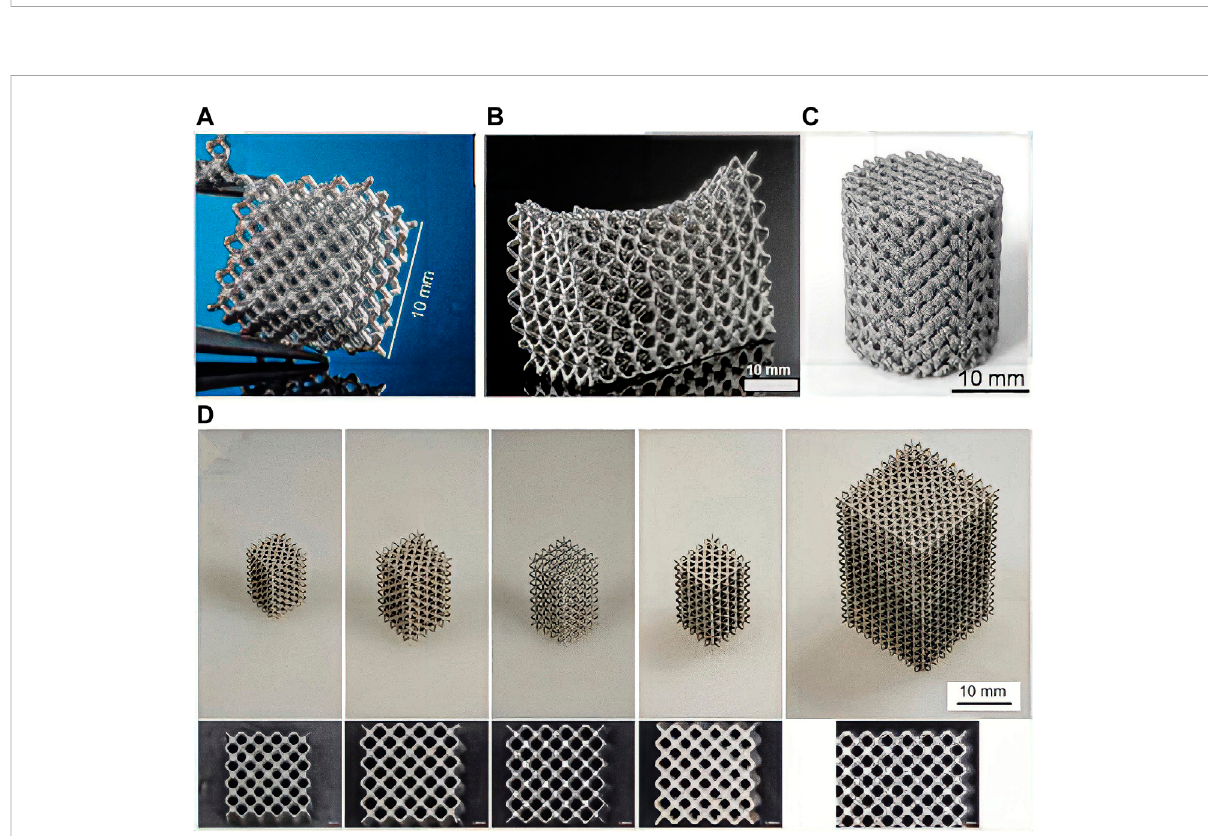
FIGURE 4 LAM WE43 scaffolds with different structural designs. (A – D) WE43 metal scaffolds made by L-PBF process.